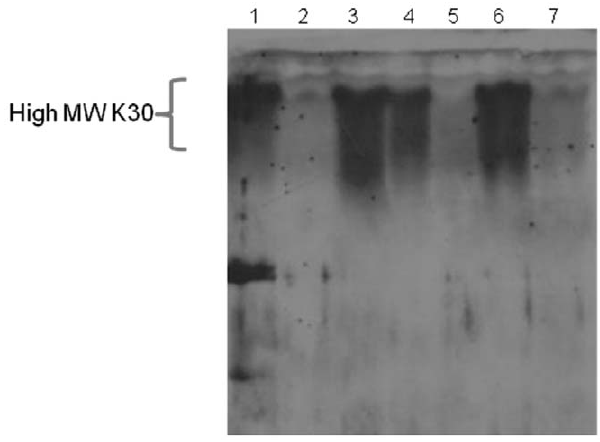
Figure 2. C.burnetii CBU0671 (GMP) restores K30 expression in the E. coli cpsB ( manC ) mutant strain CWG152. Immunoblot analysis with K30-specific antiserum of proteinase K treated whole cell lysates of 1. wild type E. coli CWG44, E. coli cpsB mutant strain CWG152, 3. E. coli CWG152/pCN603-1 ( E. coli cpsB ) induced, 4. E. coli CWG152/ pCN603-1 ( E. coli cpsB ) not induced, 5. E. coli CWG152/pBAD (vector control), 6. E. coli CWG152/pCN606-2 ( C. burnetii CBU0671) induced, 7. E. coli CWG152/pCN606-2 ( C. burnetii CBU0671) not induced.